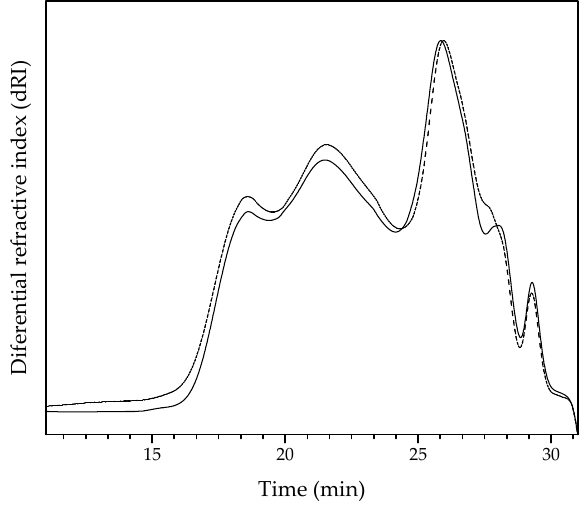
Figure 2. SE ‐ HPLC chromatograms of AX (  ) and FAX ( ‐‐ ). Figure 2. SE-HPLC chromatograms of AX ( − ) and FAX